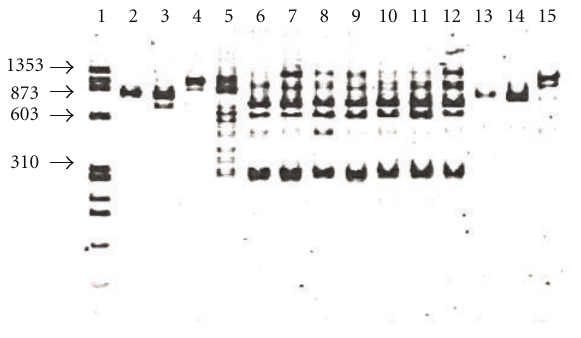
Figure 3: PCR-RFLP analysis with the endonuclease Eco RV . Lane 1, MW X174 Hae III; 2, L. (L.) garnhami JAP78; 3, L. (L.) garnhami HM76; 4, L. (L.) mexicana M379; 5, L. (L.) mexicana BEL 21; 6, L.